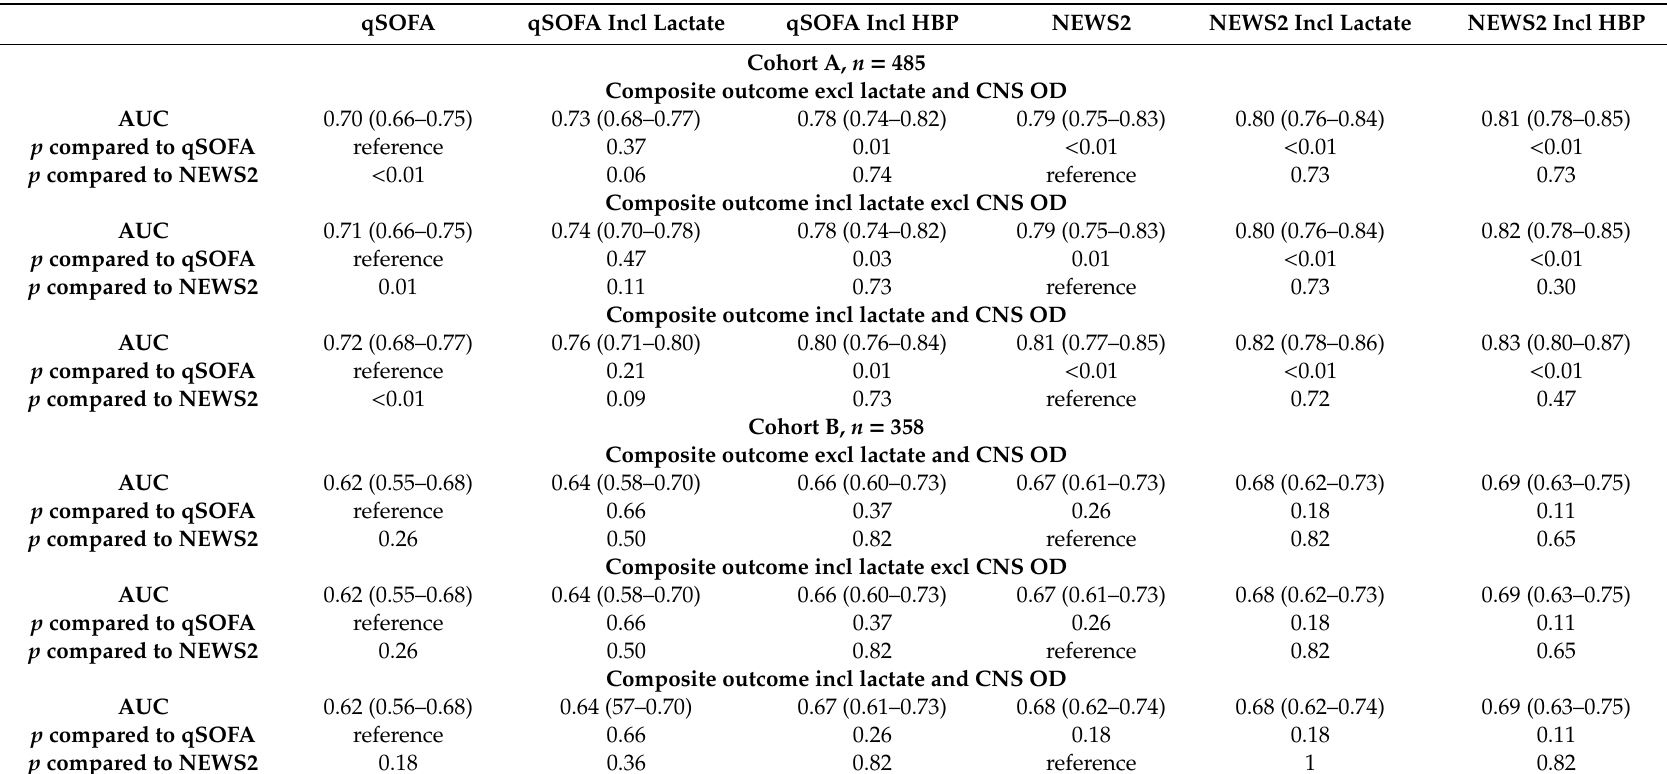
Table 4. Accuracy of risk stratification scores with biomarkers. 95% CI within brackets. Organ dysfunction